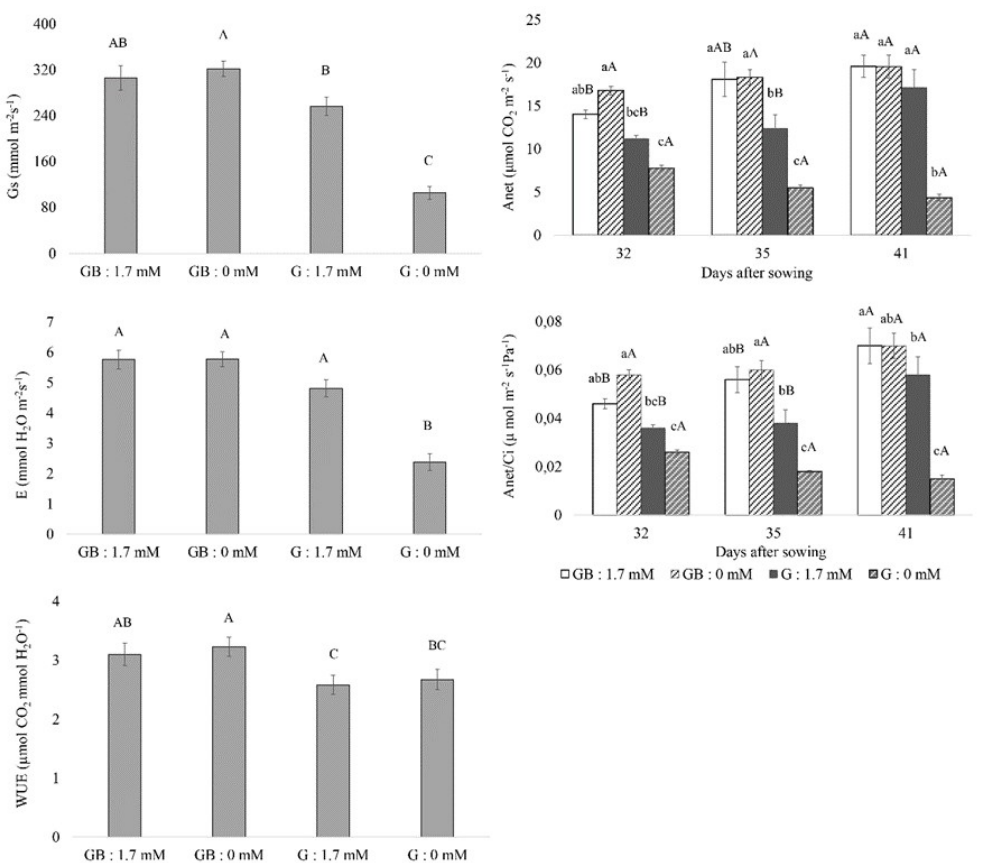
Figure 2. Gas exchange, stomatal conductance ( Gs ), CO 2 assimilation rate ( Anet ), transpiration rate ( E ), carboxylation efficiency of the RuBisCO enzyme ( Anet/Ci ) and water use efficiency (WUE) of Glycine–Bradyrhizobium and Glycine cultivated with 0 mM and 1.7 mM nitrate. Uppercase letters indicate significant differences between seasons, and lowercase letters indicate significant differences between treatments ( p < 0.05). G, Glycine ; GB, Glycine–Bradyrhizobium .